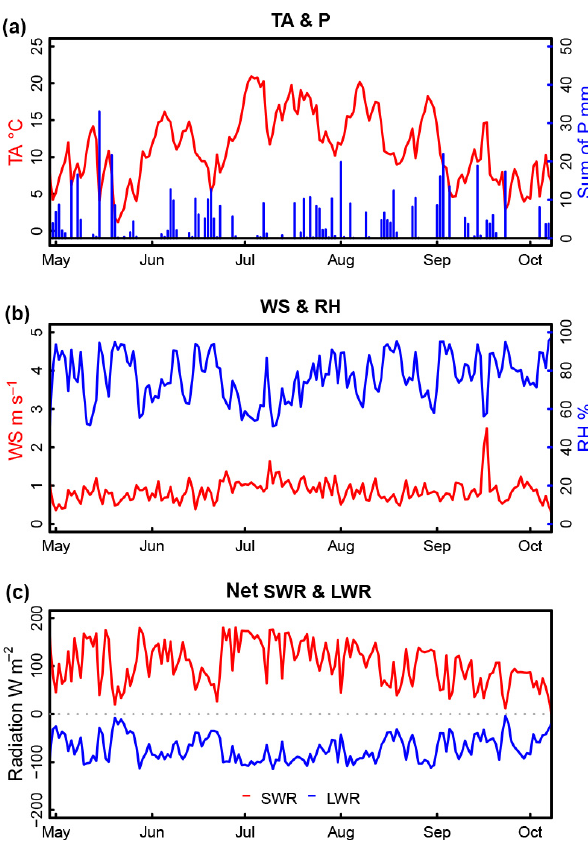
Figure 4. Meteorological input data aggregated to daily values for the Martell site. Air temperature (TA) and precipitation are shown in the upper panel, wind speed (WS) and relative humidity (RH) in the middle and net short-wave (SWR) and net long-wave (LWR) radiation in the bottom panel. Measurements were obtained from the station HM, and LWR was parametrized as described